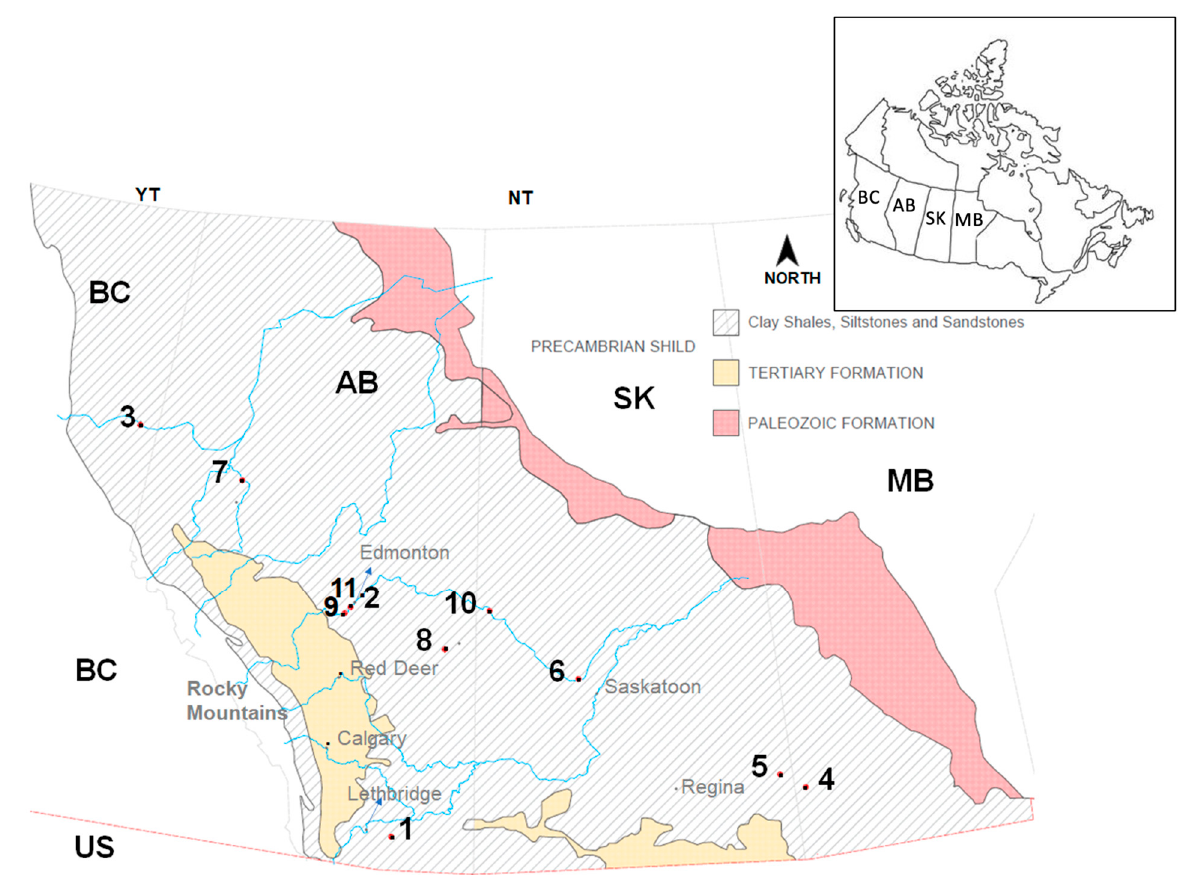
Figure 1. The interior Plains (adapted from [1,2]) and location of the landslides used in this study. Provinces shown include British Columbia (BC), Alberta (AB), Saskatchewan, (SK), and Manitoba (MB). Red dots are landslide locations, black dots are cities. Blue are major rivers.